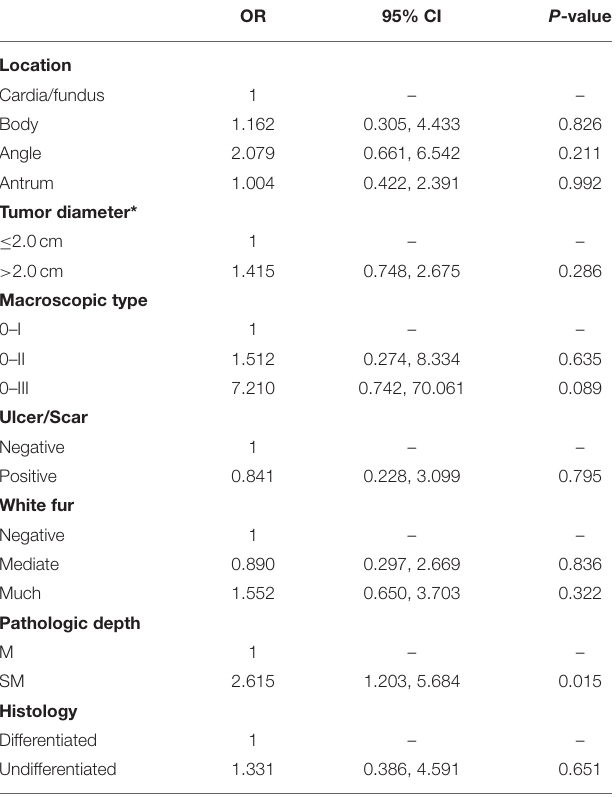
TABLE 4 | Multivariate analysis of factors associated with misdiagnosis of EUS in estimating the depth of EGC invasion. OR 95% CI P -value